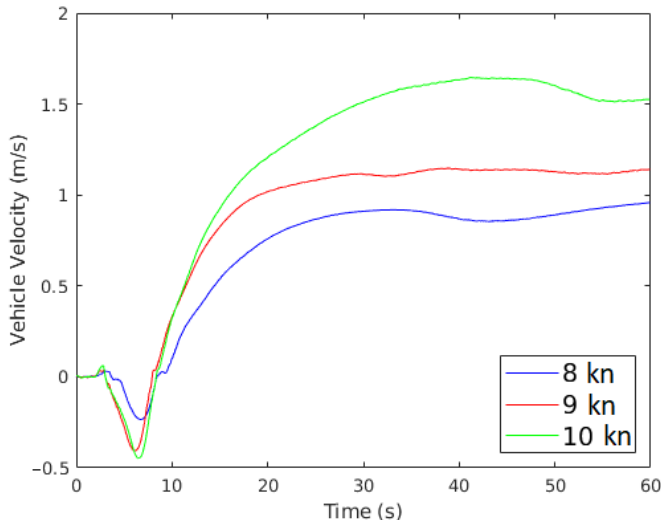
Figure 13. Vehicle velocity over time ( K p = 0.05, K d = 0.07, α i = 90°, α f =